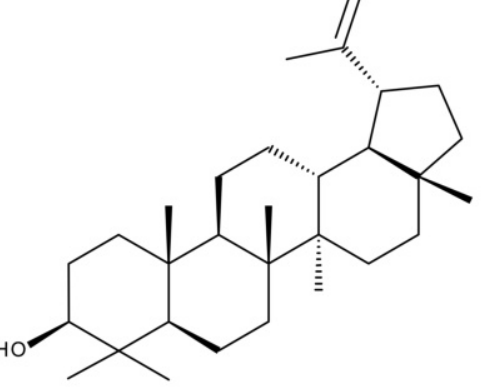
Figure 24. Chemical structure of